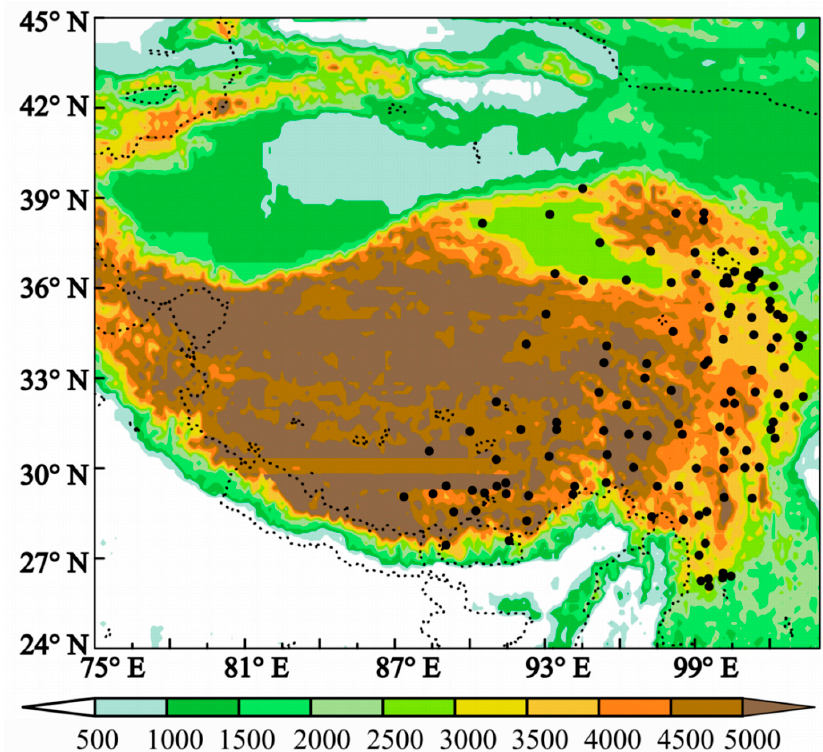
Figure 1. Distribution of stations over the Tibetan Plateau. The shade represents altitude (unit: m).